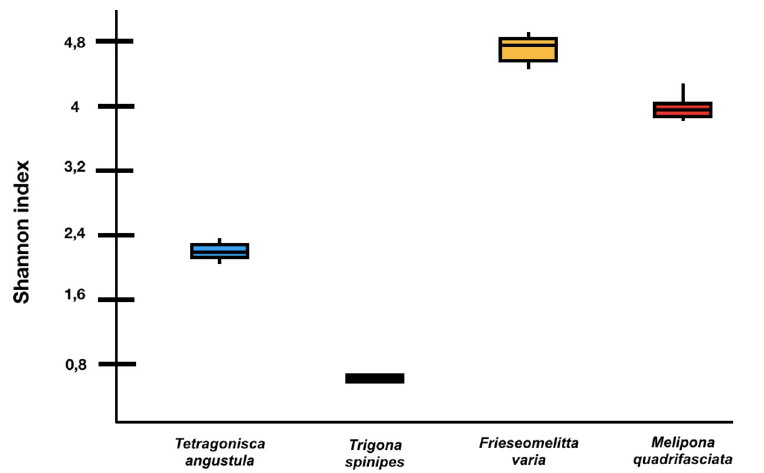
Fig 3. Shannon´s diversity index of indoor surface of the nests (p < 0.01; Nemenyi